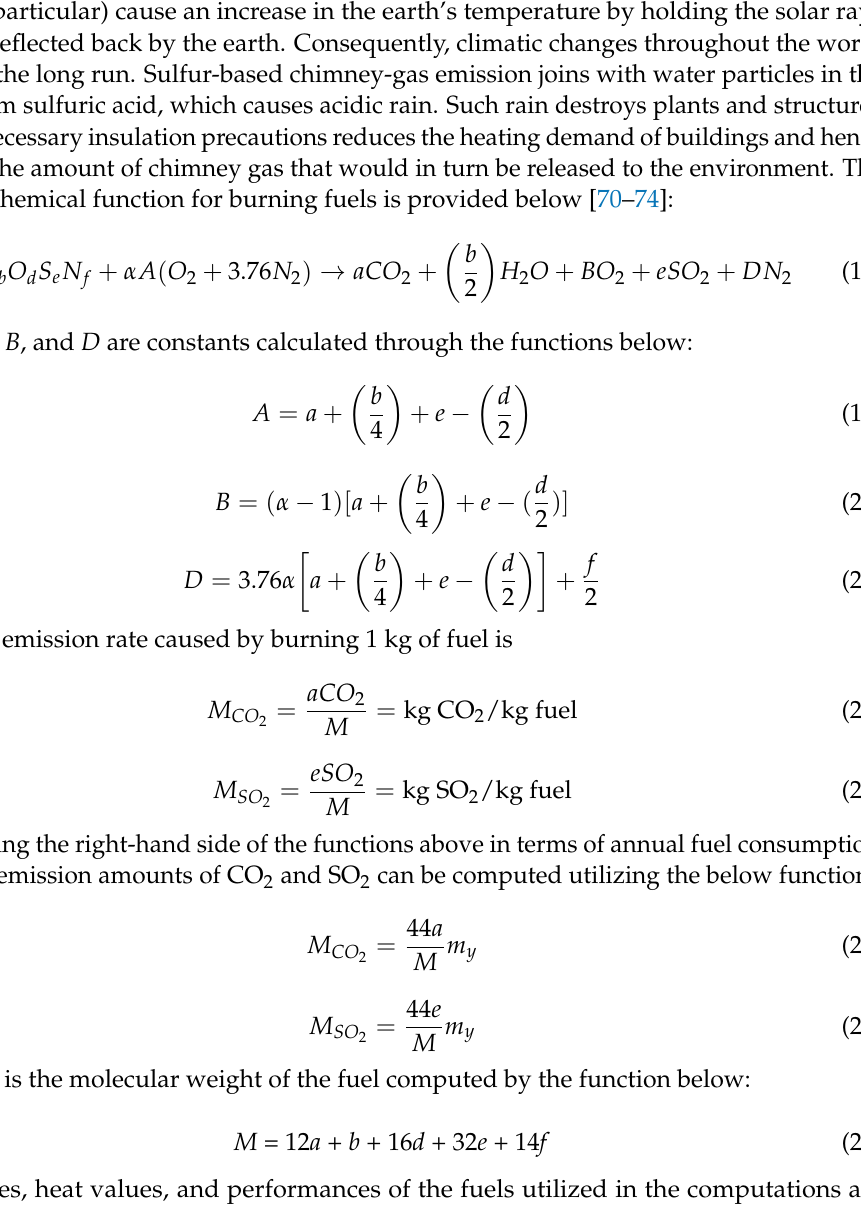
Table 3. Prices, heat values, efficiencies, and chemical formulas of the fuels [35,36]. Energy Type Chemical Formula